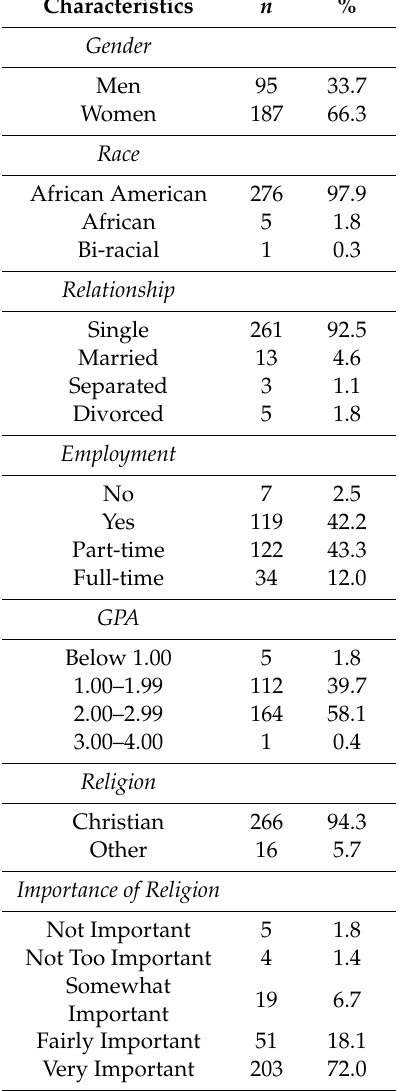
Table 1. Summary of sample characteristics ( n =